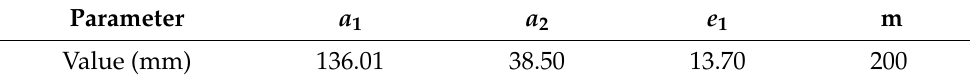
Table 5. Forearm and Elbow CAD Mechanical Design